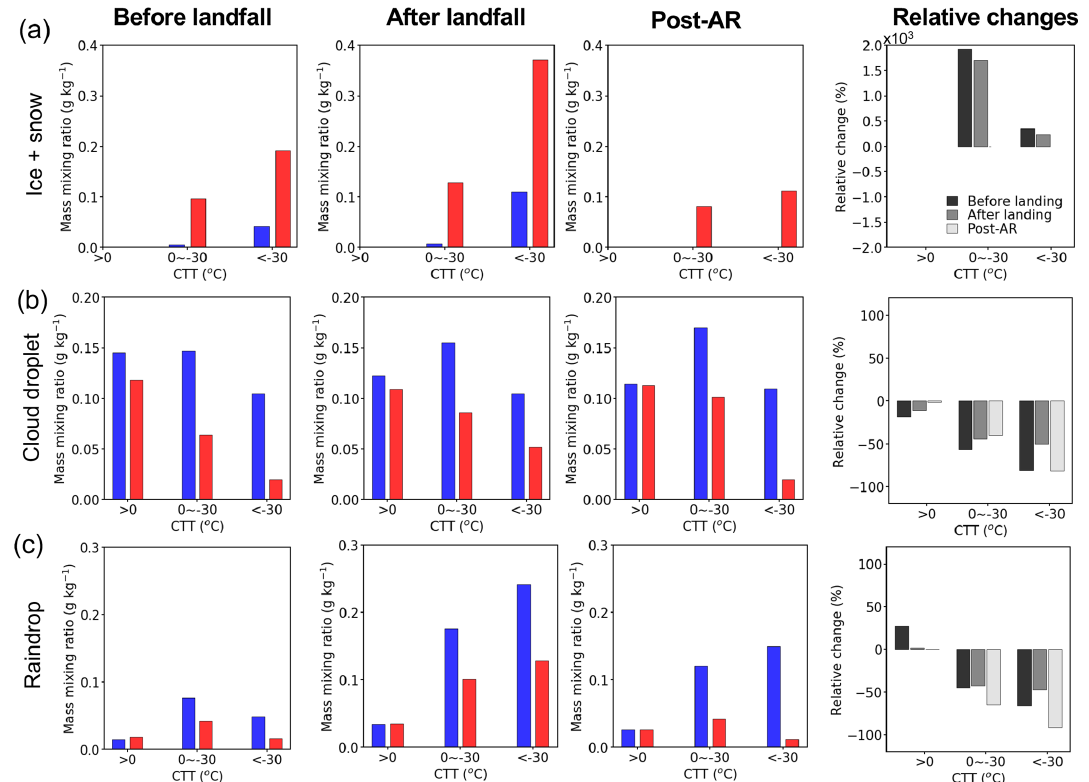
Figure 13. Same as Fig. 12, except for the mass mixing ratios of (a) ice particles (sum of ice and snow), (b) cloud droplets, and (c)